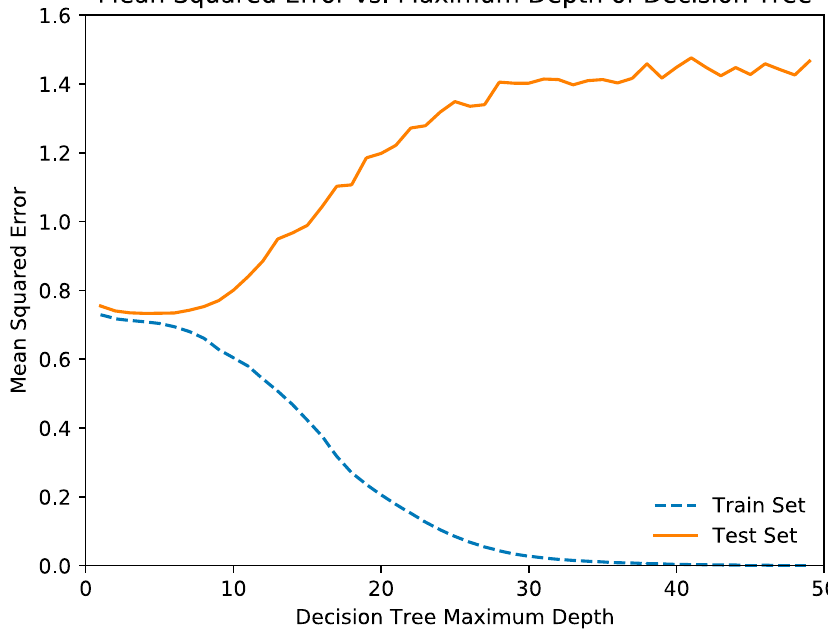
Figure 2. The relationships of the decision tree depth with the mean squared error. Table 3. Metrics for the random forest (RF) regression model for cost.